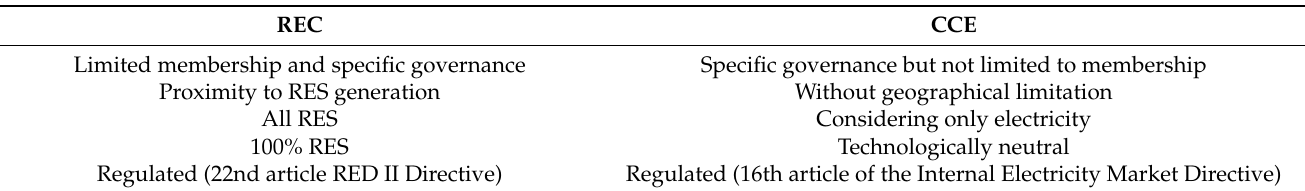
Table 2. Differentiating characteristics of REC and CCE (Adapted from